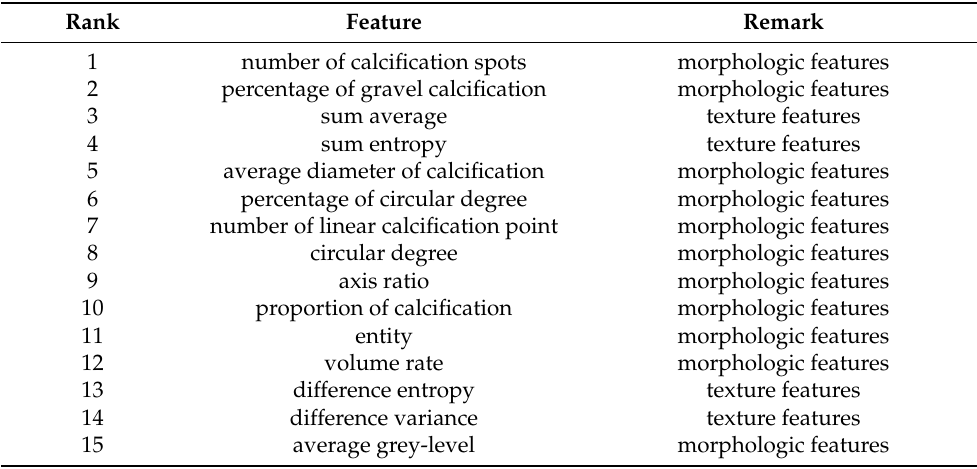
Table 3. Top 15 important calcification features after feature